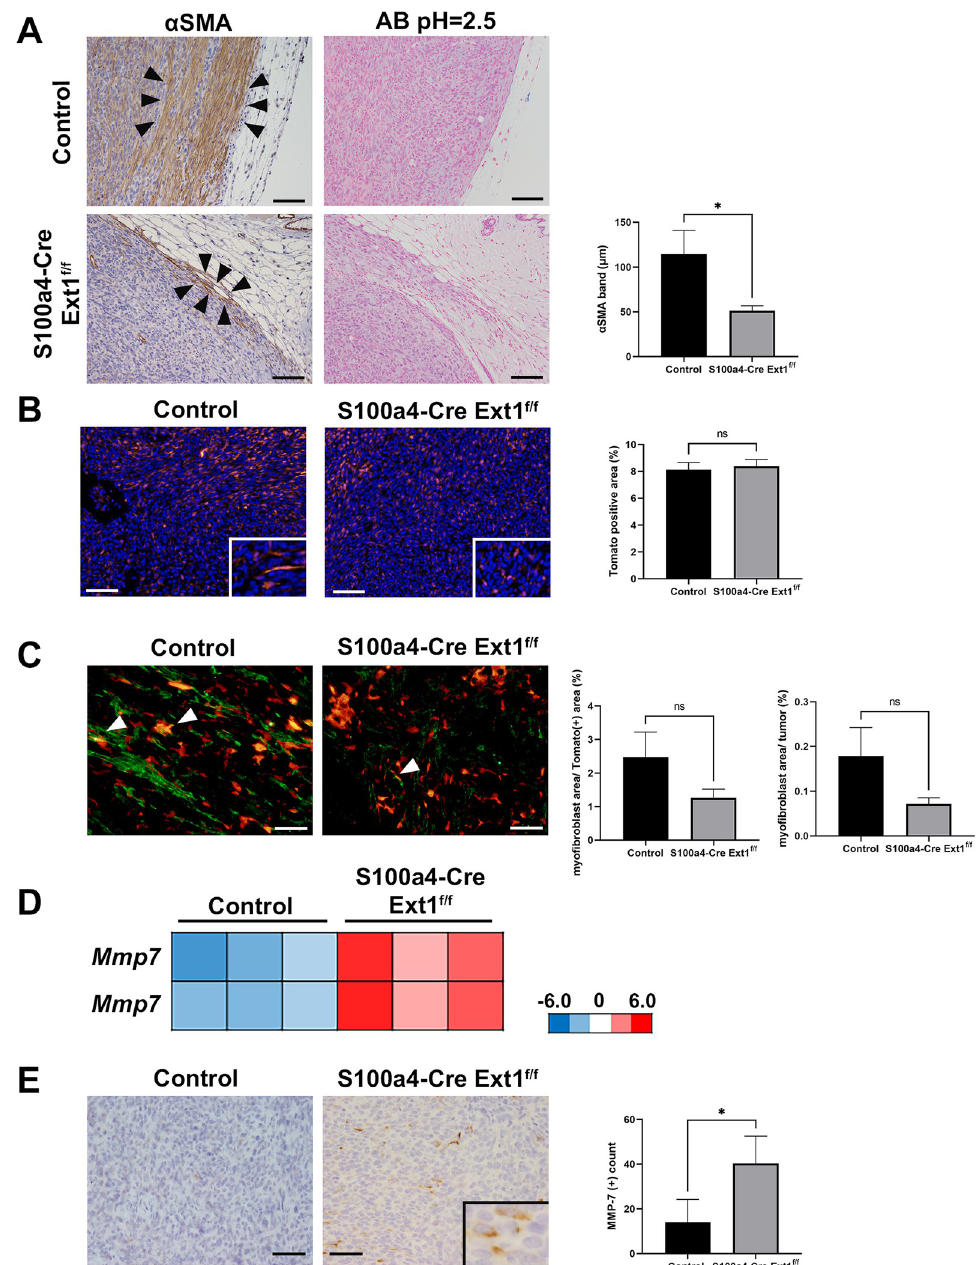
Fig 5. Decreased myofibroblasts in the peritumoral region and high expression of MMP-7 in Pan02 S.C. tumor of S100a4-Cre; Ext1 f/f mice. (A) Immunostaining of α -smooth muscle actin ( α SMA)-positive spindle cells, i.e., myofibroblasts, in the peritumoral region of Pan02 S.C. pancreatic tumors in S100a4-Cre; Ext1 f/f and control mice (left). Arrowheads indicate the band comprising α SMA-positive cells. Alcian blue staining (pH = 2.5) in the peritumoral region of Pan02 S.C. pancreatic tumors in S100a4-Cre; Ext1 f/f and control mice (middle). Measurement of the thickness of myofibroblasts around the Pan02 S.C. tumor of S100a4-Cre; Ext1 f/f and control mice (right). Data represented as mean ± SEM (N = 6 for each cohort, unpaired t-test, � P < 0.05). Scale bar = 100 μ m. (B) Tomato expression in the intra- tumor region of Pan02 S.C. tumors of S100a4-Cre; Ext1 f/f ; Lsl-tdTomato and control ( S100a4-Cre; Lsl-tdTomato ) mice. Measurement of the area of Tomato-positive cells in both cohorts. Data represented as mean ± SEM (N = 6 for each cohort, Mann–Whitney test). Scale bar = 100 μ m. (C) Immunofluorescent staining of α SMA (green) in the Pan02 S.C. tumors of S100a4-Cre; Ext1 f/f ; Lsl-tdTomato and control ( S100a4-Cre; Lsl-tdTomato ) mice (left). White arrowheads indicate α SMA-positive fibroblasts. Measurement of the percentage of the area of α SMA-positive fibroblasts, i.e., myofibroblasts, in Pan02 S.C. tumors of S100a4-Cre; Ext1 f/f ; Lsl-tdTomato and control ( S100a4-Cre; Lsl-tdTomato ) mice